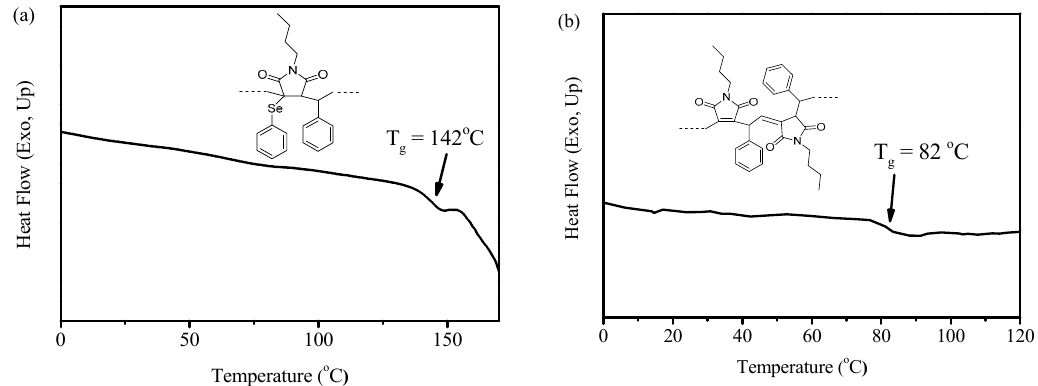
Figure 8. Differential scanning calorimetry (DSC) spectra of copolymers: ( a ) before oxidization ( b ) after oxidization.